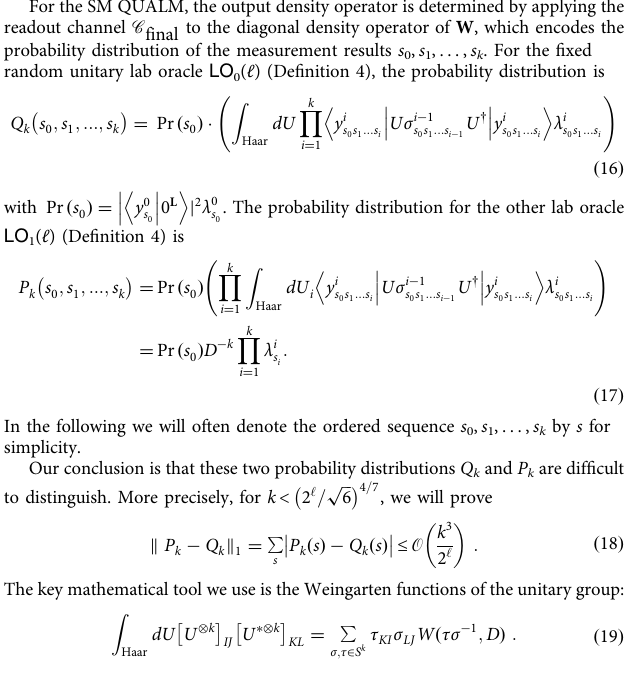
Fig. 2 Circuit for a simple measurement QUALM. (Left) Illustration of the simple measurement QUALM de fi ned in De fi nition 14. The upward pointing triangles indicate the weighted projection ρ The horizontal solid lines indicate the recording of POVM measurement results in W i . The horizontal dashed lines connected to downward pointing triangles indicate the preparation of initial state σ s previous measurement results s 0 , . . . , s i . (Right) Illustration of the incoherent access QUALM de fi ned in De fi nition 13. Each orange solid circle is a CP map and each blue box is a CPTP map. At least one of the CP maps between each application of the lab oracle is a complete measurement, indicated by the double triangle. The direction of the arrow in each horizontal dashed line indicates the direction of classical information fl ow. Only the LOCC ’ s corresponding to β i , j and x i lead to conditional probabilities that depend on the lab oracle, which are indicated by red dashed